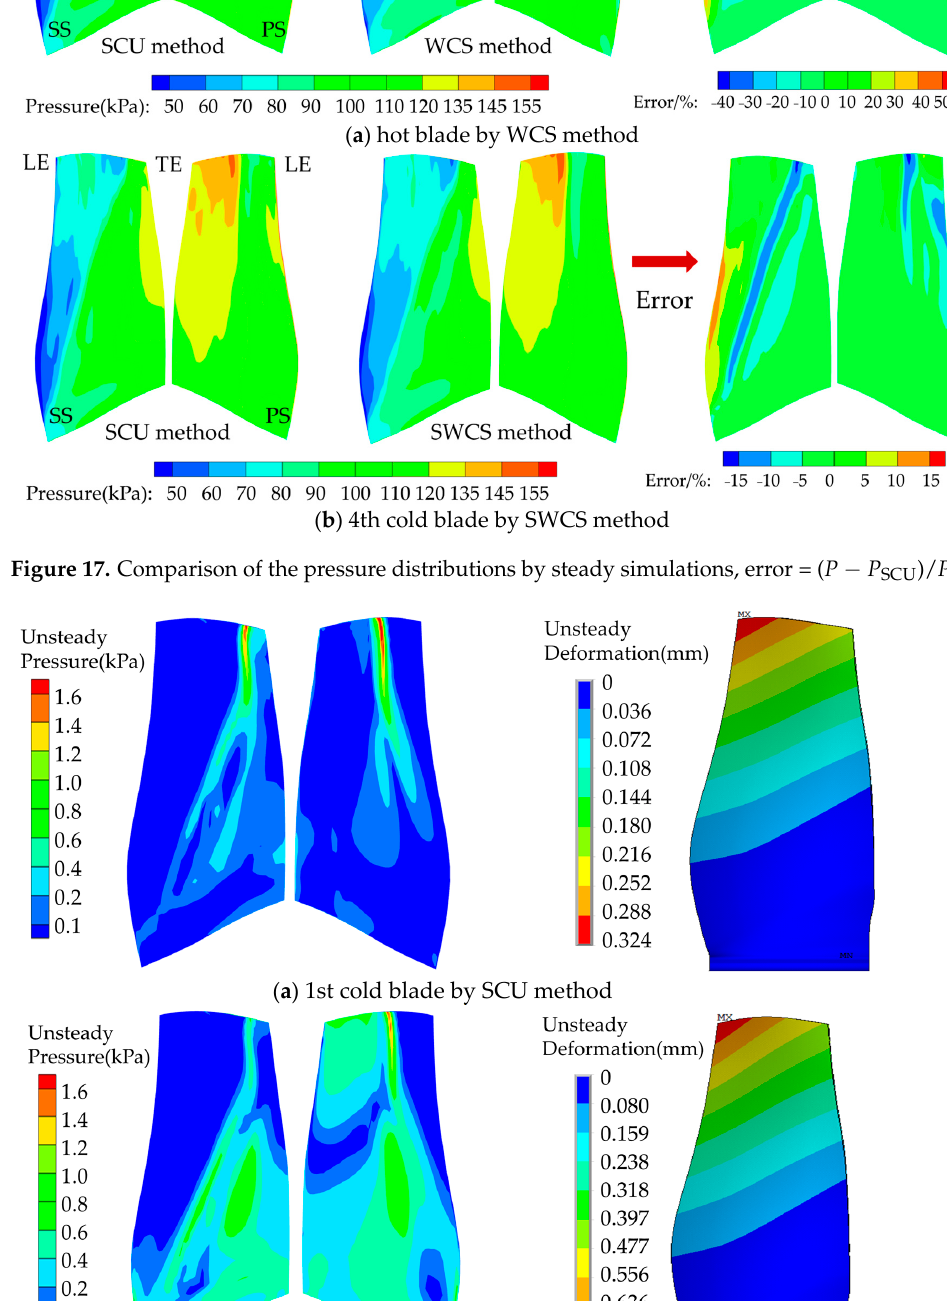
Figure 18. Pressure distributions and deformations of unsteady simulations by SCU method.